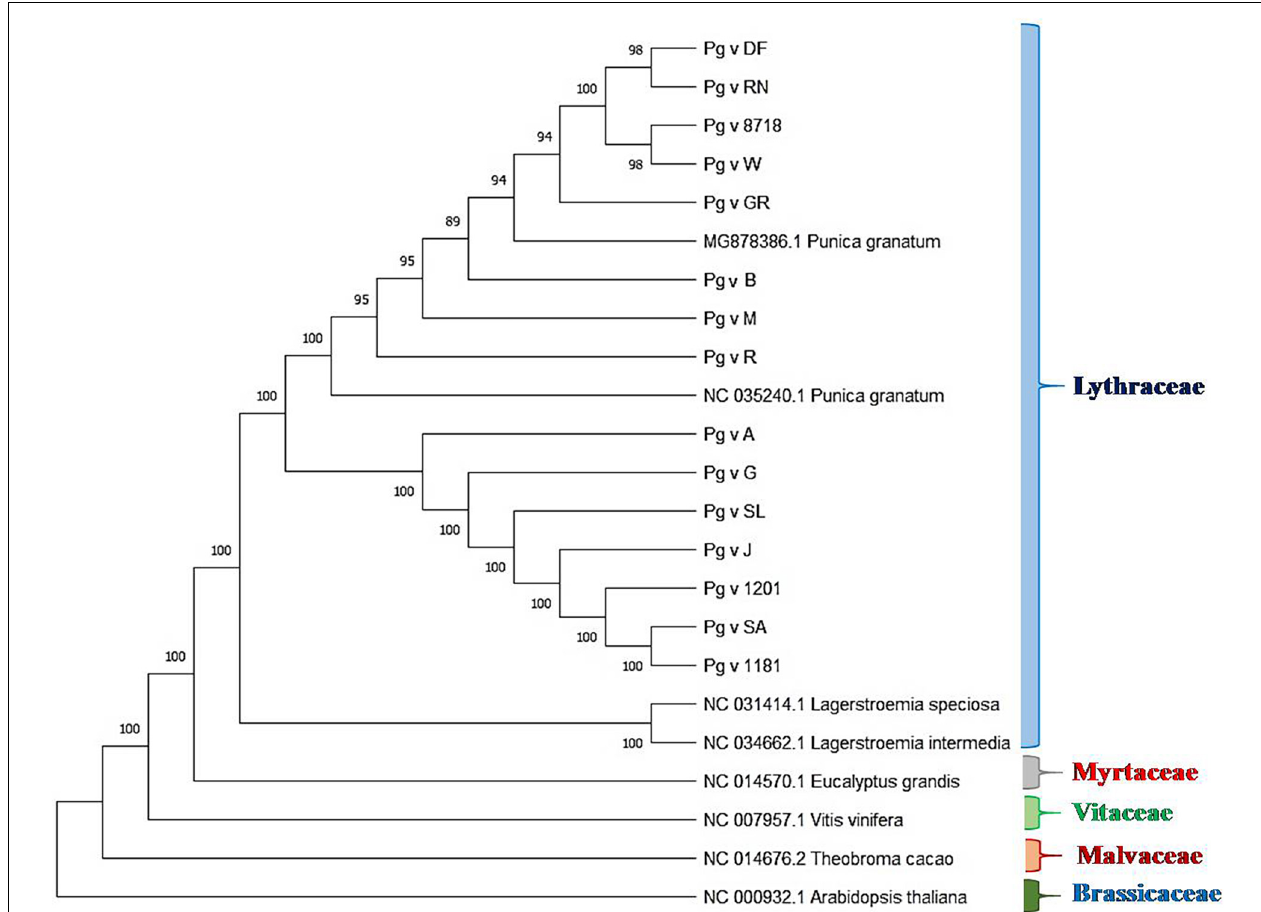
FIGURE 6 | Rooted phylogenetic analysis based on cp genome sequences of different pomegranate genotypes and related